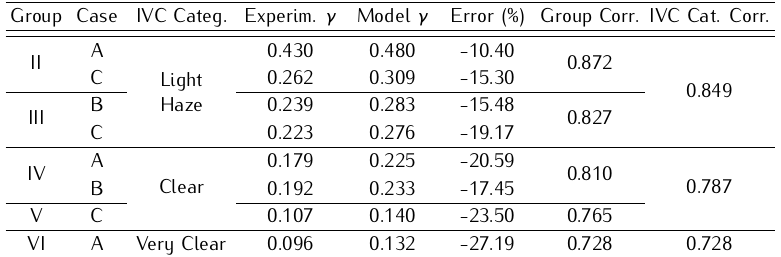
Table 13. Transmittance data and ESLM model corrections ( λ = 1064 nm – SR = 4